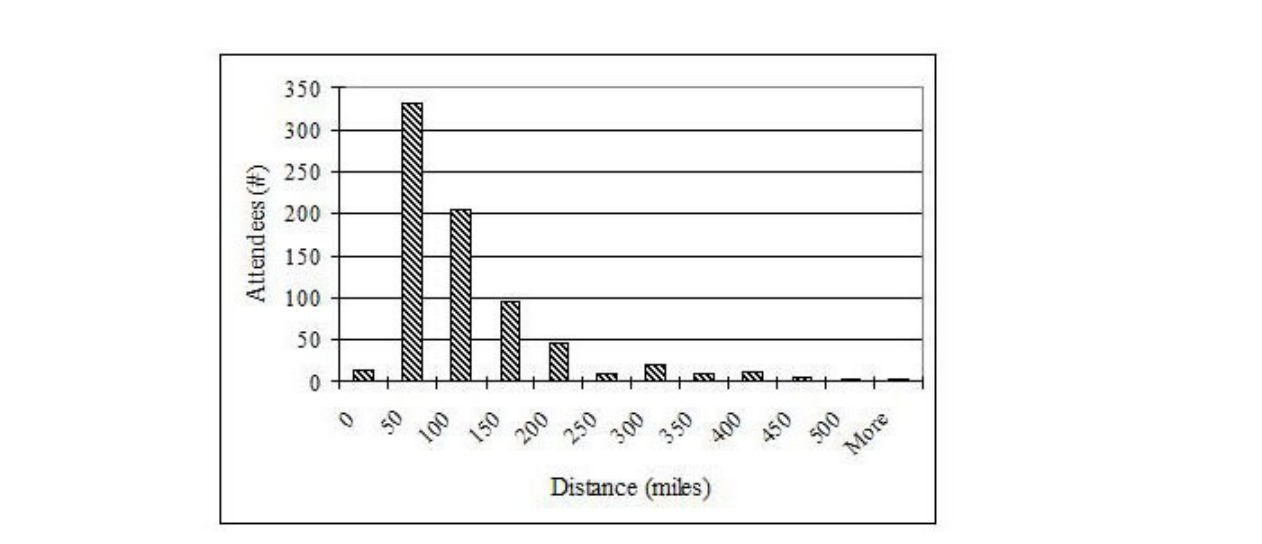
Fig. 3. Distribution of groundfish attendee